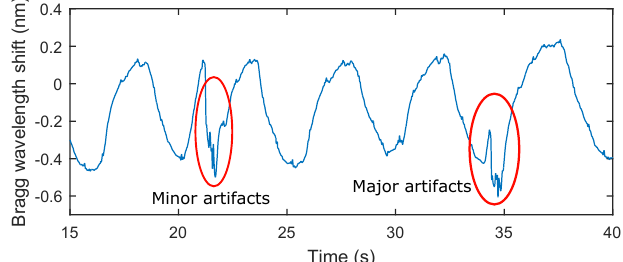
Figure 9. A recording from a subject in this study (M2). Subject M2 was asked to change his position and to simulate strong coughing. For example, the influence of a position change on the respiratory rate is shown in red on the left (minor artifacts) and the influence of strong coughing on the breathing rate is shown in red on the right (major artifacts).